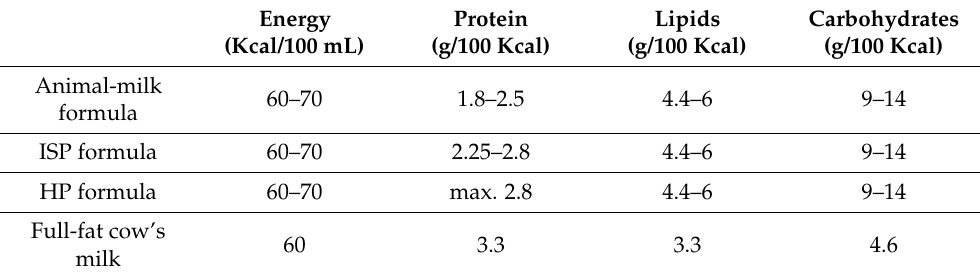
Table 1. Energy and macronutrient composition of infant and follow-on formulas [39,40]